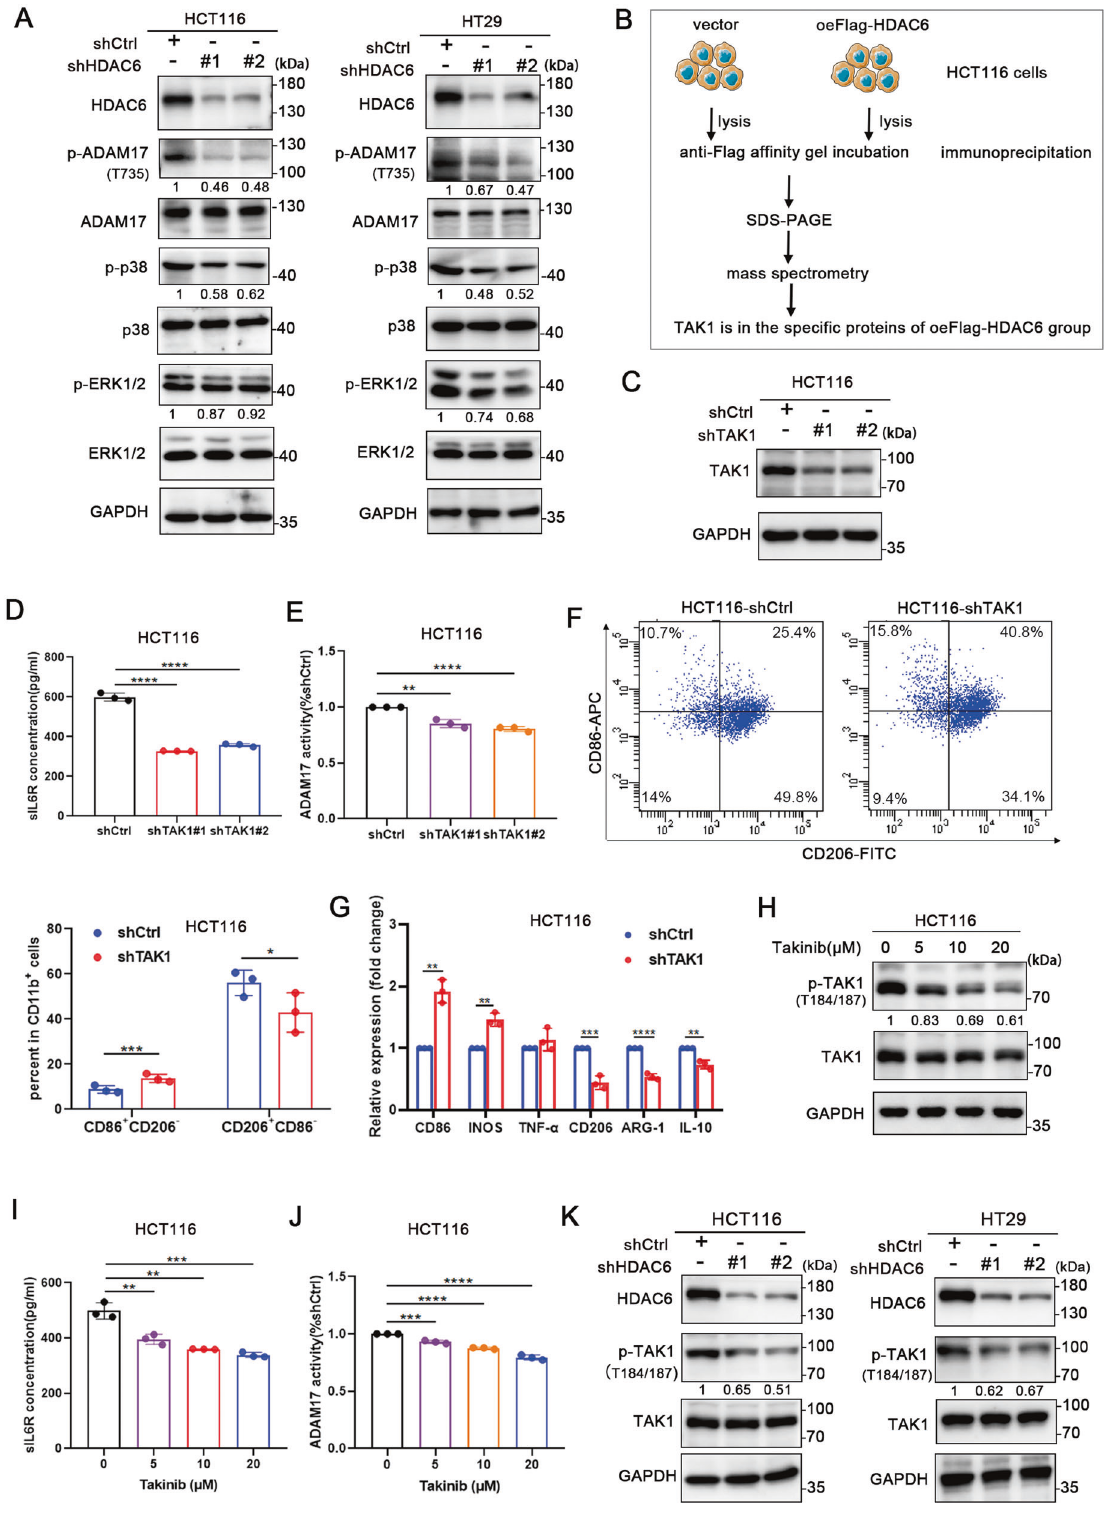
phosphorylation of STAT3 in the macrophages cocultured with HCT116 cells. Compared to control cells, the phosphorylation of STAT3 in macrophages signi fi cantly decreased after